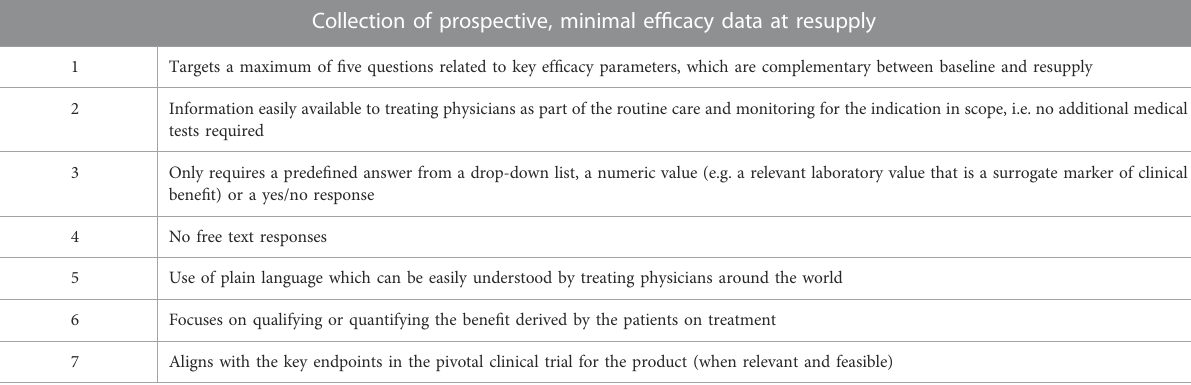
TABLE 1 Principles applied to prospective data collection at product resupply in the Novartis online system. Collection of prospective, minimal ef fi cacy data at